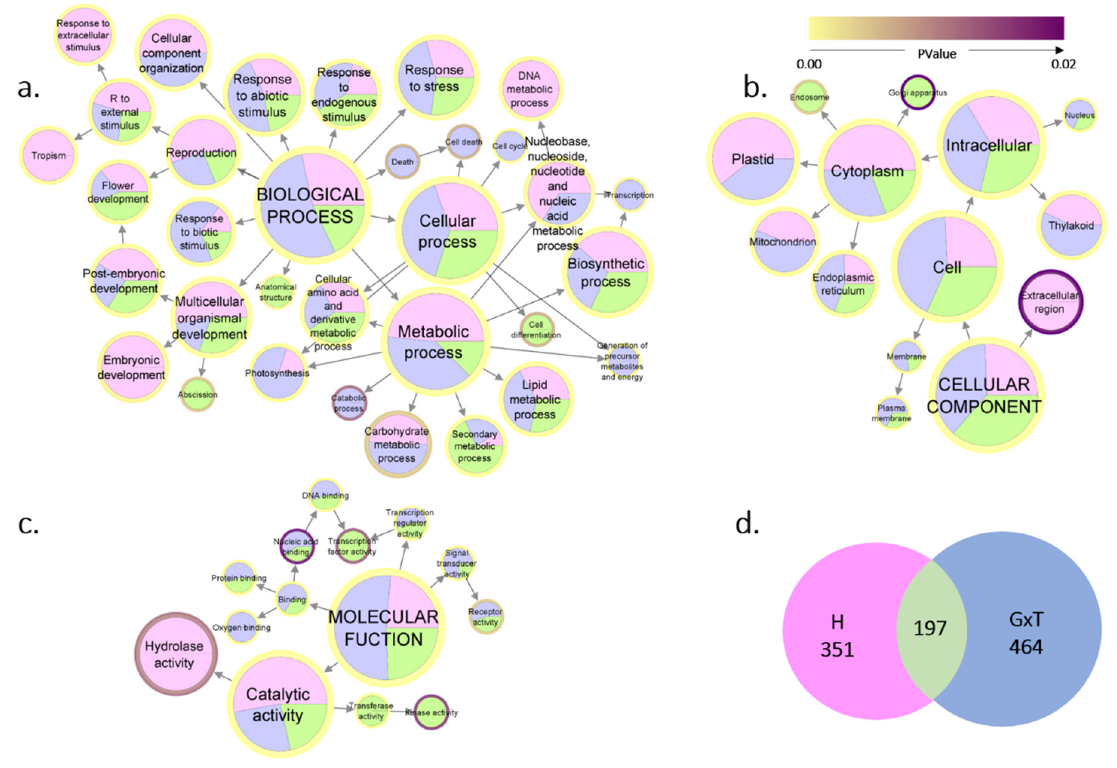
Figure 2. Functional enrichment analysis performed for all DEGs in flowers with the BINGO plugin in Cytoscape. Assigned GO terms were used to classify functions of DEGs based on ( a ) biological processes, ( b ) molecular functions, and ( c ) cellular components. Circle size represents GO hierarchy; the larger area of the circle, the higher hierarchy of the GO-term. The border colour of nodes represents the p-value, as shown by the legend on the graph; the deeper the shade the more significant the enrichment level. The threshold of hypergeometric distribution of the functional annotation was set at p < 0.05 and FDR < 0.05. ( d ) Venn diagram showing the number of differentially expressed genes between female ‘ Hayward ’ (H) and male ‘ Green Light ’ x ‘ Tomuri ’ (GxT) female flowers.